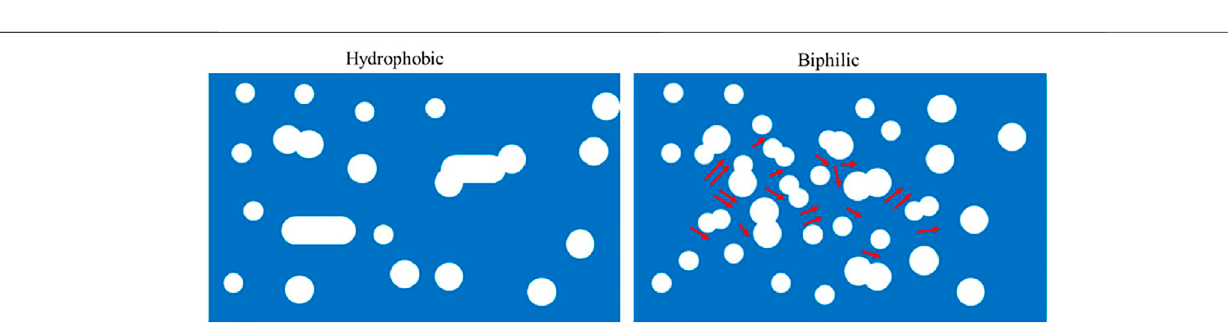
FIGURE 7 | Visualization results regarding mass fl ux of 90 kg/ m 2 s.